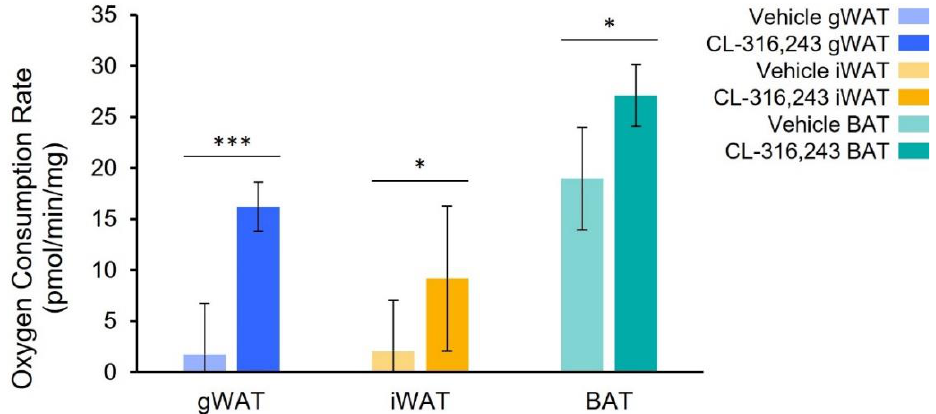
Figure 3. Basal metabolic rate from selected fat pads in CL-316,243 treated and vehicle mice. CL-316,243 treatment increased the metabolic rate significantly in all fat pads, n = 5 for all groups (* indicates p < 0.05, *** p < 0.001).